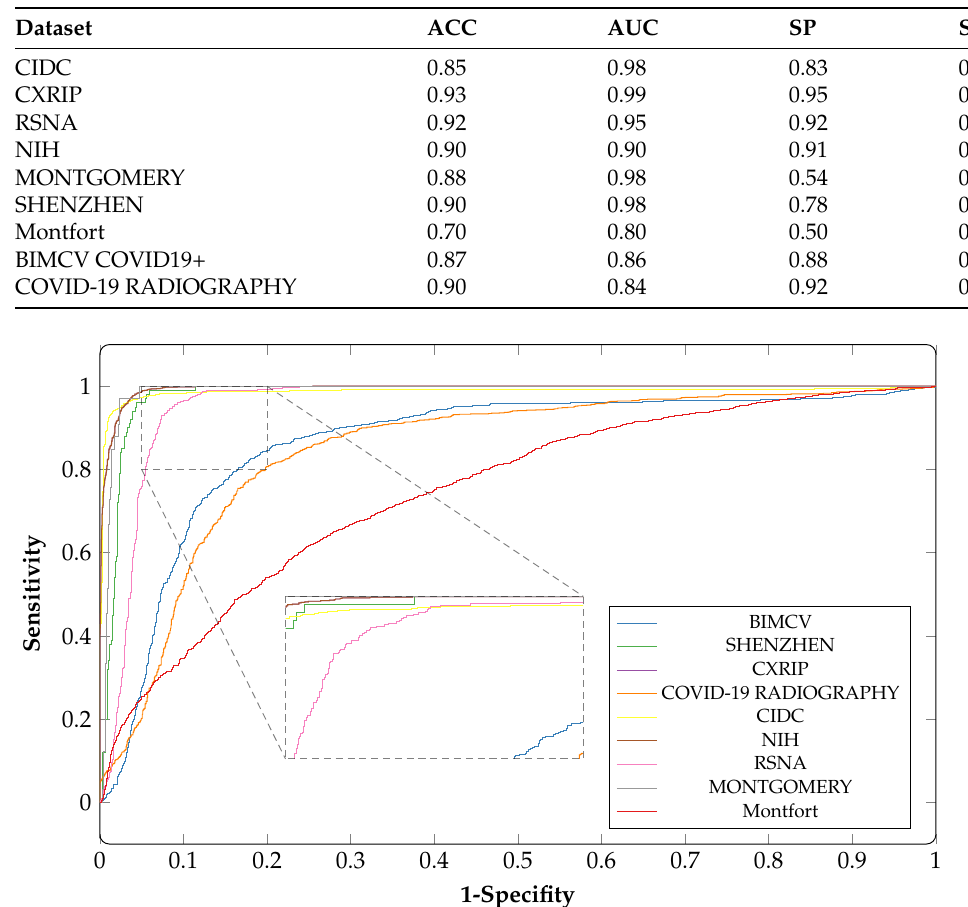
Figure 22. ROC curves of DeepCCXR-Bin for detecting COVID-19 in nine datasets. Table 6. Performance measures of DeepCCXR-Multi for COVID-19 detection in nine datasets.